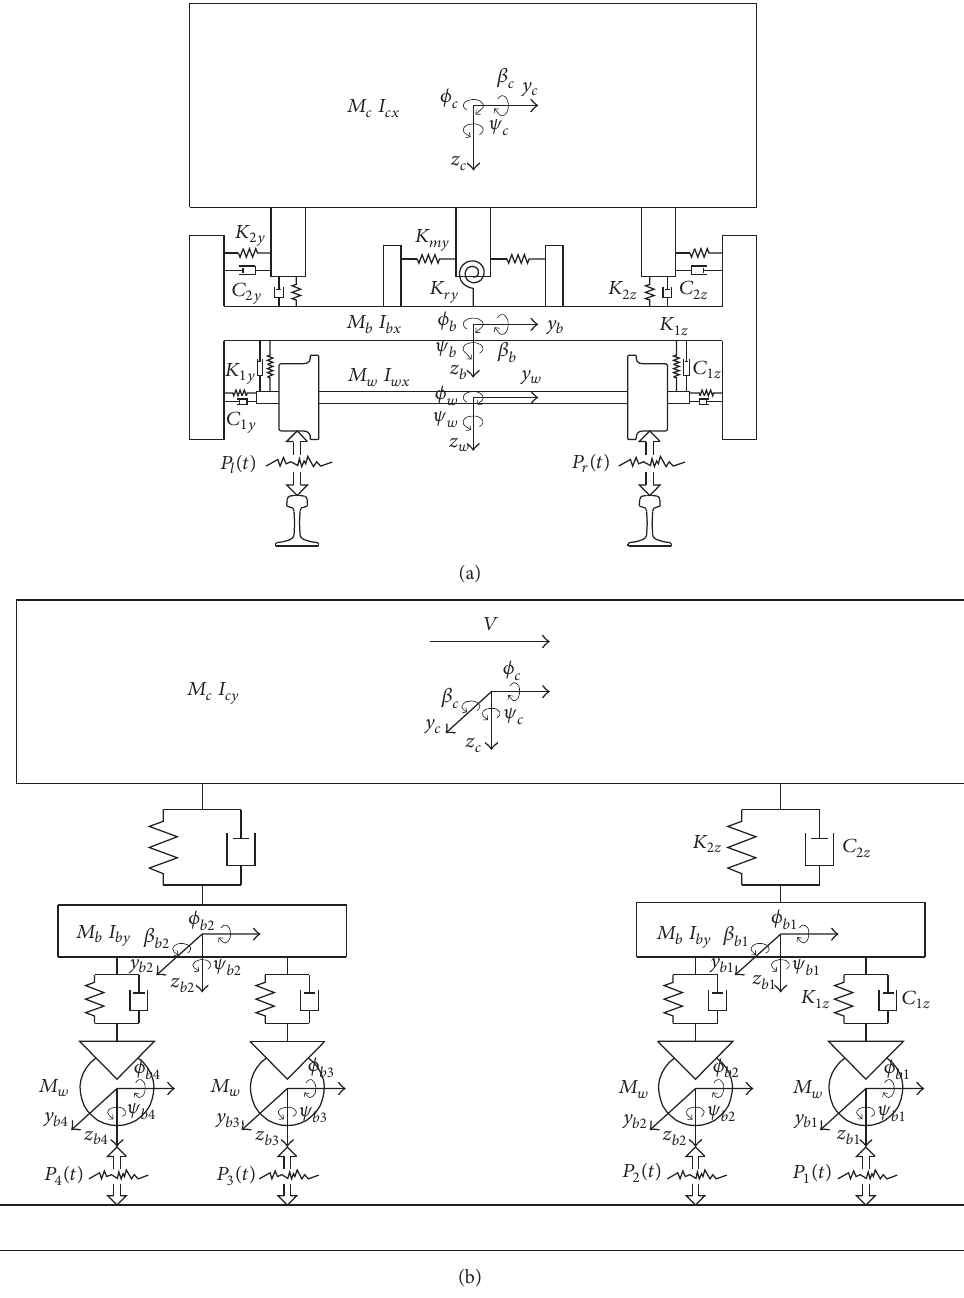
Figure 6: Dynamic model of a high-speed vehicle. ((a) end view; (b) elevation view).